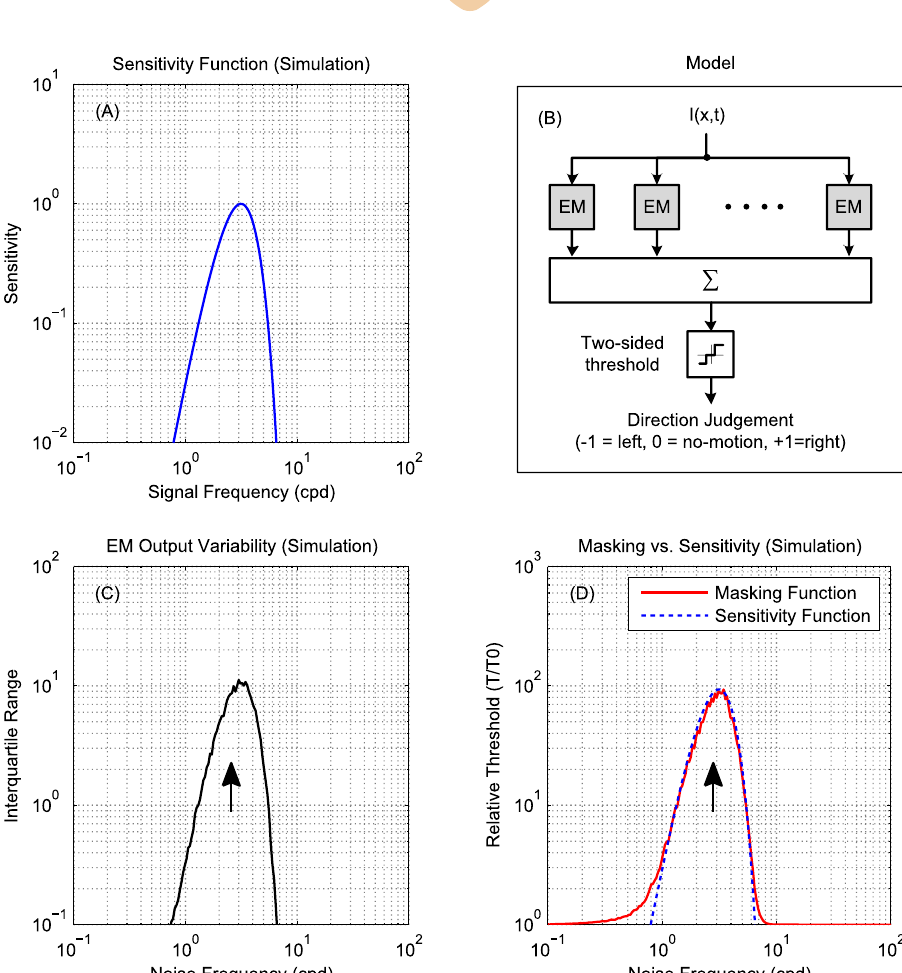
Figure 4. For mammalian bandpass filters, the masking function reflects sensitivity. ( A ) Spatial sensitivity function of a mammalian band-pass energy-model motion detector, i.e., its response to single drifting gratings as a function of the grating spatial frequency. ( B ) Direction discrimination model based on an array of opponent models with the spatial tuning plotted in panel A. Opponent model outputs are pooled and passed through a two-sided threshold of value T to produce a ternary judgment of motion direction per stimulus presentation. ( C ) The variability of opponent model outputs across 500 simulated presentations (per noise frequency point) of a noisy stimulus consisting of a signal grating of 3 cpd and temporally-broadband noise. Signal frequency is marked on the plot with an arrow. Signal and noise had 2 and 20 2 RMS contrast respectively. Adding noise did not change the mean of opponent output but had a significant effect on its spread. Output variance was highest when noise frequency was 3 cpd and lower as noise frequency changed in either direction, closely resembling the shape of the opponent model’s sensitivity function. ( D ) The masking function (red) was calculated based on these simulated results as T ( f n )/ T 0 where T ( f n ) is the threshold corresponding to a 90% detection rate at each noise frequency and T 0 is the detection threshold of an unmasked grating. The sensitivity function from ( A ) is reproduced, scaled, for comparison (blue dotted line). The masking function is a good approximation to the